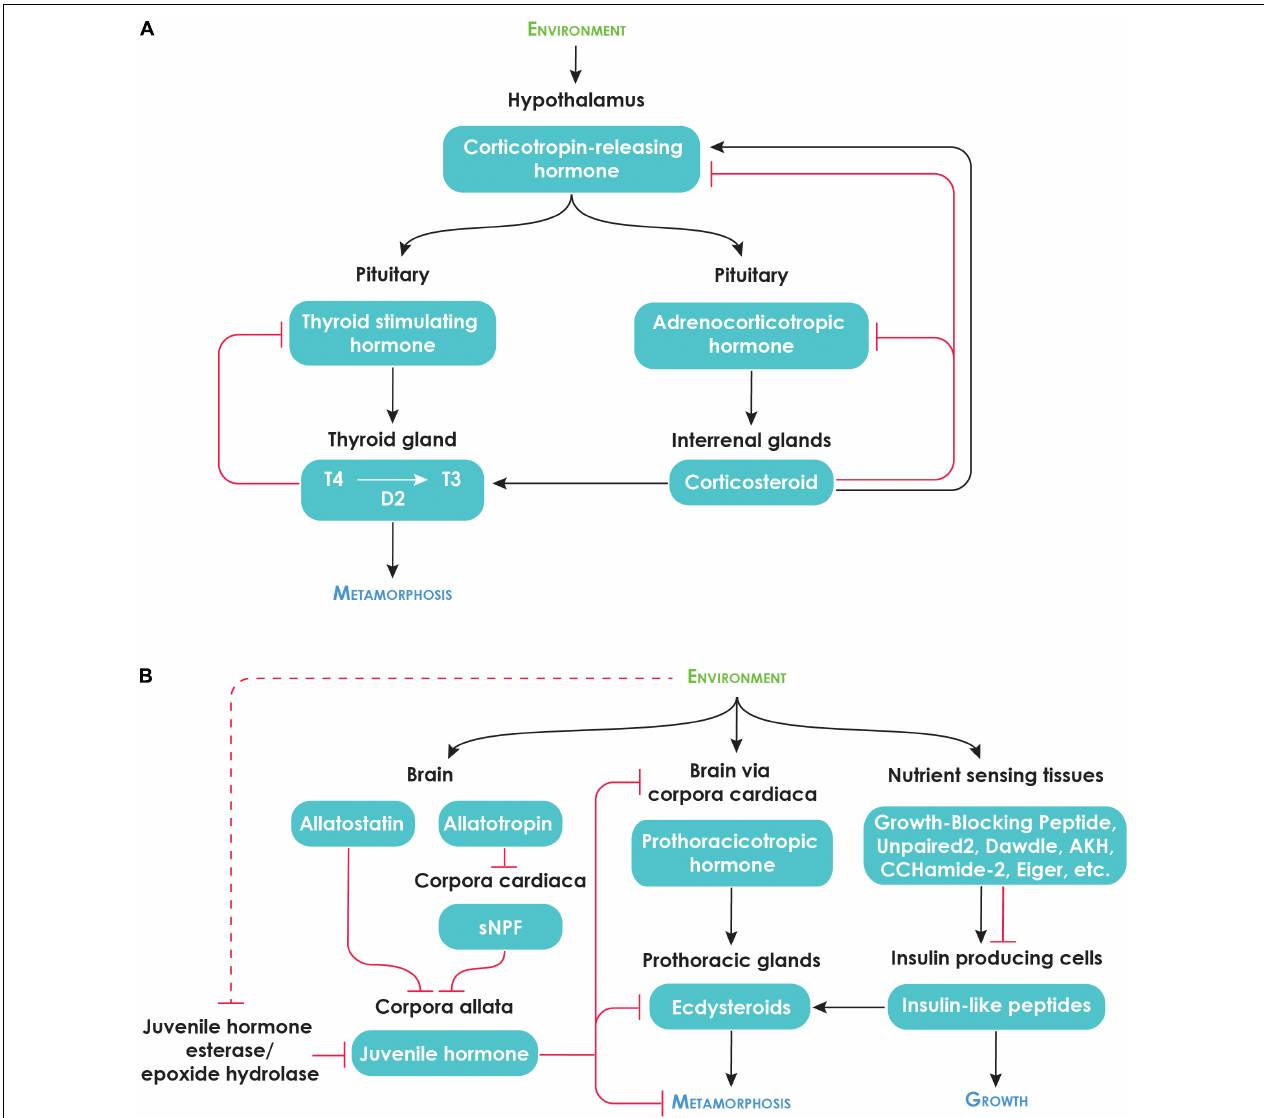
FIGURE 2 | Neuroendocrine regulation of metamorphosis. (A) Metamorphic regulation of amphibians [Modified from Denver (2013)]. (B) Hormonal regulation of insect growth and metamorphosis. The details of JH regulation are based on lepidopteran studies. Many of the regulators secreted by the nutrient-sensing tissues were identified in Drosophila melanogaster . We do not yet know how conserved these factors are across all insects. Dotted red line indicates effect of stress on JH esterase